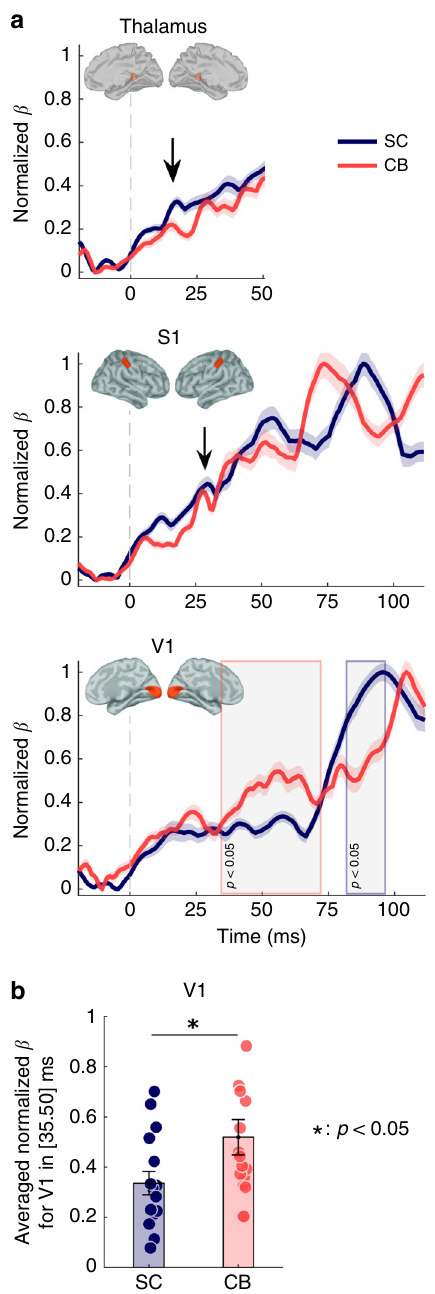
Fig. 2 Linear regression model of ROI contributions to MEG data. a Temporal variations of the linear mixing model coef fi cients shown in each region of interest, following electrocutaneous stimulation of the index fi nger (0 ms). The data from left and right index fi nger stimulation were pooled for greater statistical power. The linear coef fi cient time series are shown for contralateral posterior thalamus (top, with early peak marked with an arrow), primary somatosensory (S1, middle), and visual (V1, bottom) ROIs in CB and SC subjects. Shading indicates standard error of the mean estimates. Gray-shaded boxes highlight segments of signi fi cant differences between the two groups ( p ≤ 0.05), with their borders colored according to the group showing stronger V1 contribution (two-tailed independent t test, p ≤ 0.05 — not corrected for multiple comparison due to a limited number of participants). The thalamus model coef fi cients are shown only over the fi rst 50 ms after stimulus onset to emphasize the early peak around 20 ms (black arrow). b Average model coef fi cients in V1 within the [35, 50]-ms time window showed greater V1 contribution in CB vs. SC. Mixed model ANOVA with hemisphere as within-subject variable and group as between- subject variable: no main effect of hemisphere or interactions between hemisphere and group, but signi fi cant effect of group ( F (1) = 15.6, p = 0.001) re fl ecting stronger activity in V1 for CB